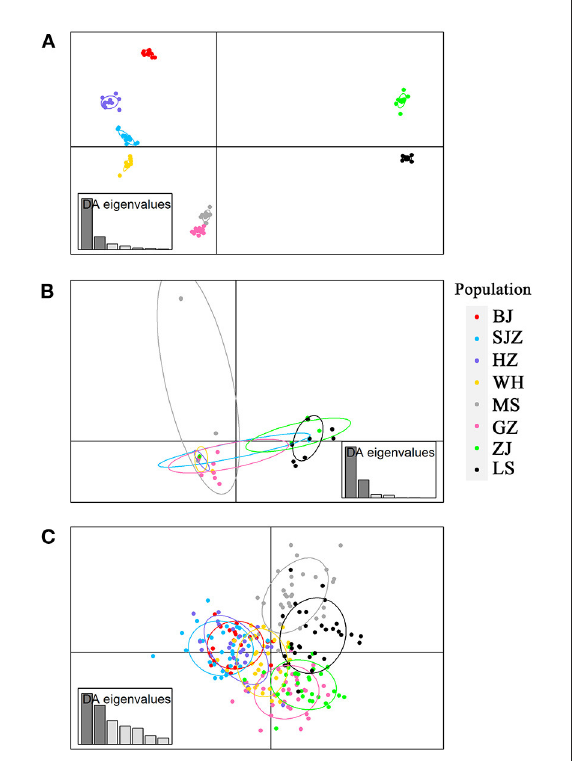
FIGURE3 Discriminant analysis of principal components (DAPC) plots for genome-wide SNPs (A) , cox 1 (B) and microsatellites (C) in eight field populations of Ae. albopictus in China. The plots show the relationship between individuals belonging to eight different populations (represented by colored dots, where the color of a dot corresponds to a